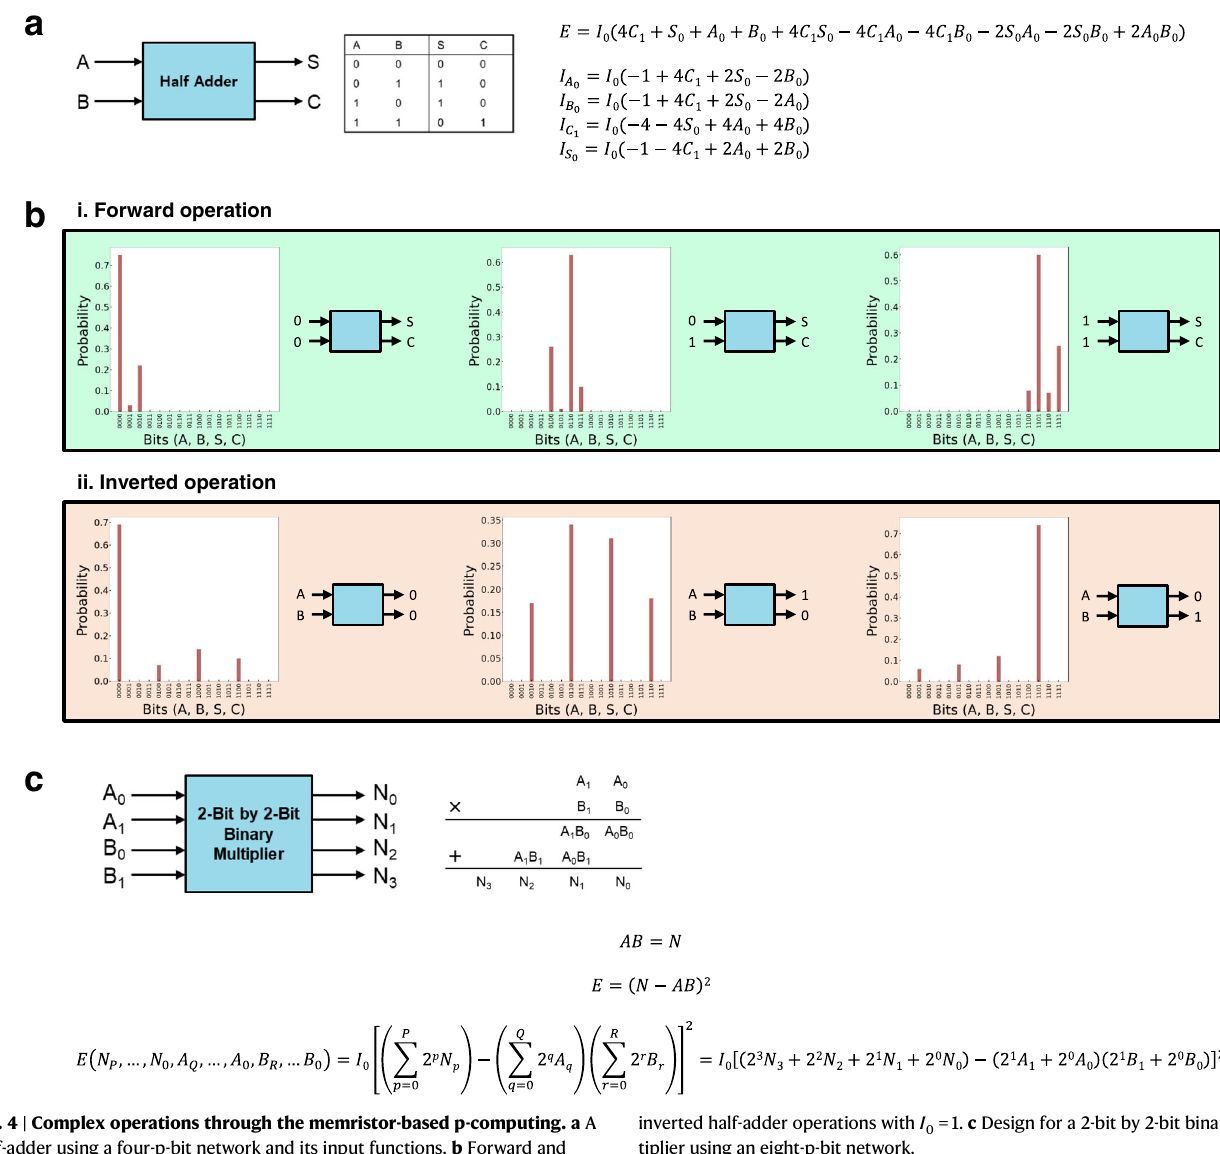
inverted half-adder operations with I 0 =1. c Design for a 2-bit by 2-bit binary mul- tiplier using an eight-p-bit